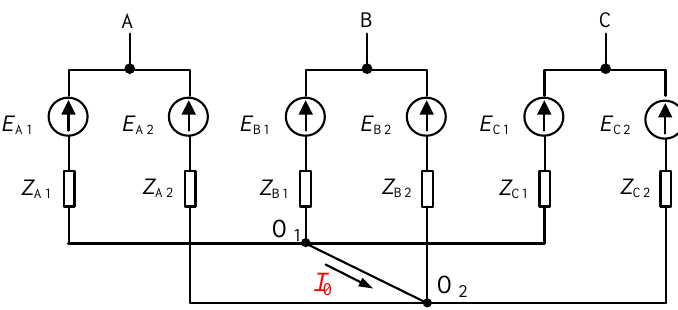
Figure 3. Equivalent circuit of the generator stator windings.